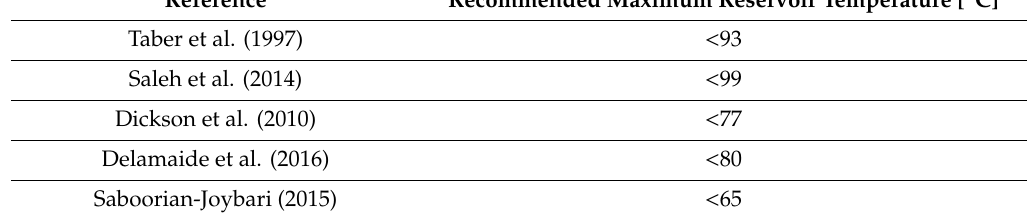
Table 3. Literature recommended maximum reservoir temperatures for polymer flooding in oil reservoirs (modified after